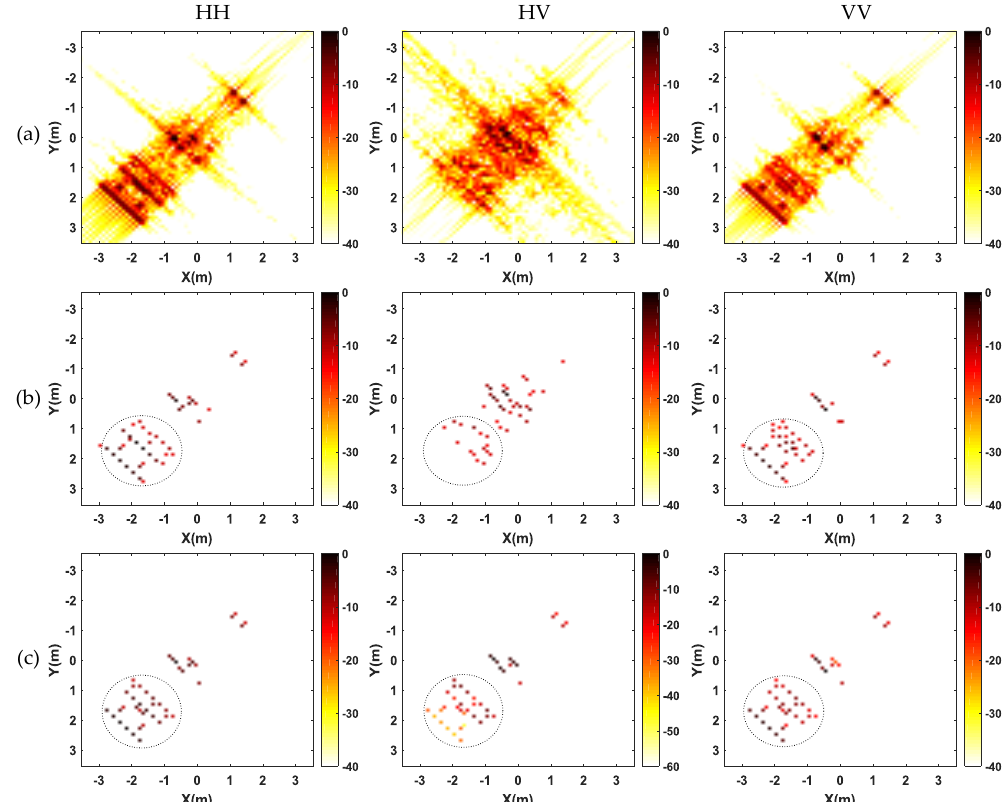
Figure 10. Comparison of imaging results by different imaging methods. ( a ) Traditional filtered back-projection method; ( b ) single channel CS method; and ( c ) multichannel joint CS method.